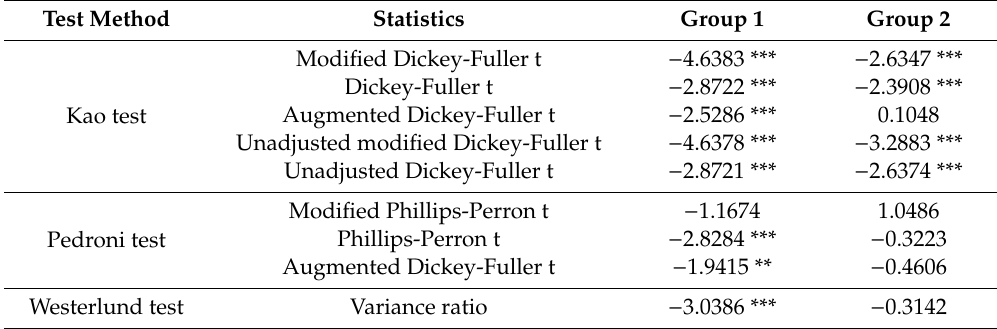
Table 7. Panel cointegration test.